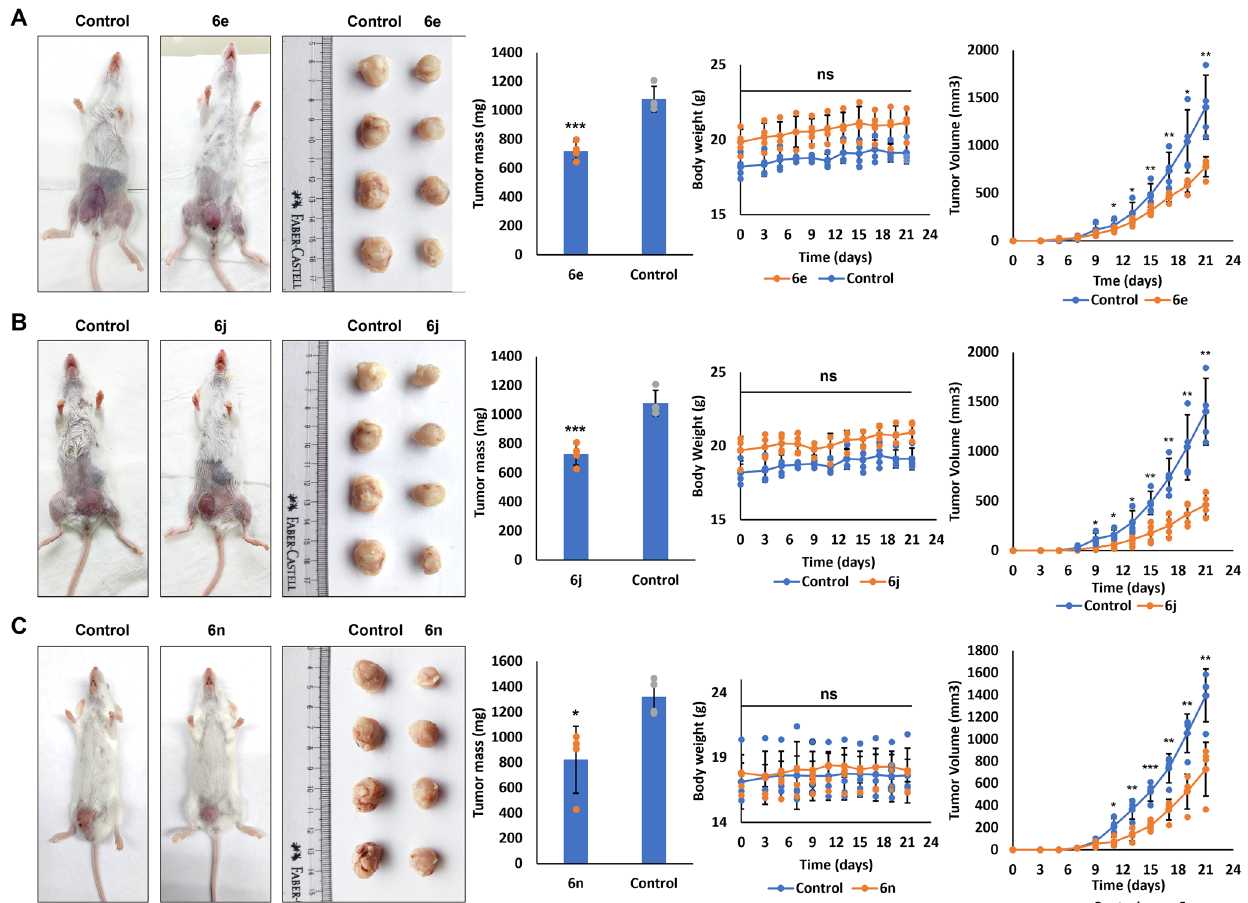
Fig. 10 cATC derivatives 6e, 6j, and 6n inhibit tumor growth in vivo. 4T1 cell derived tumor was induced in Balb/C mice and the animals were treated with 6e , 6j, and 6n compounds (1 mg/kg/day, 0.5 mg/kg/day, and 1 mg/kg/day, respectively) starting from day 8 till day 20, post tumor induction. A – C The representative images of mice with tumor. Right-hand side images show tumors from mice treated with cATC derivatives 6e ( A ), 6j ( B ) and 6n ( C ) and DMSO (control). Bar graphs (left) and line graph (middle) show average tumor mass and body weight in each group, respectively. Graphs in right show external tumor volume measured every alternative day. Each group had four animals. Values are mean ± SD; two-tailed unpaired Student ’ s t test was used for calculating P values; ns represents non-signi fi cant, * represents p -value ≤ 0.05, ** represents p -value ≤ 0.01, *** represents p -value ≤ 0.001 and, **** represents p -value ≤ 0.0001, N represents experiment